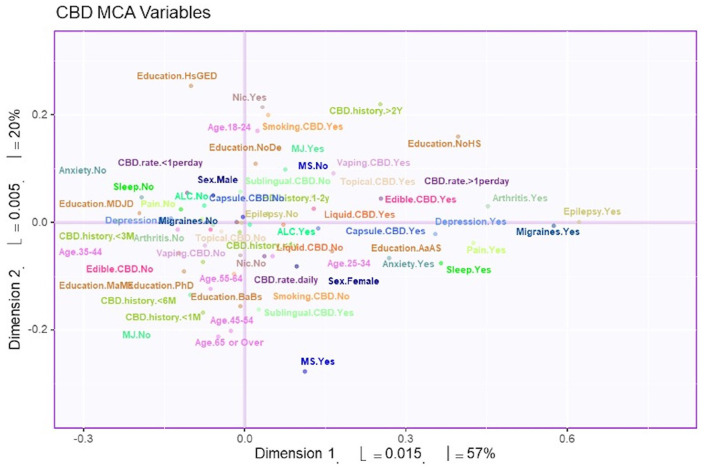
Survey variables plotted on dimensions 1 and 2. The variable factor scores plotted to show dimensions 1 and 2. These two dimensions account for 77% of the total variance. Distance from the axis indicates the association of the variable to the dimension. In addition, two points that are close to each other have greater association with each other.